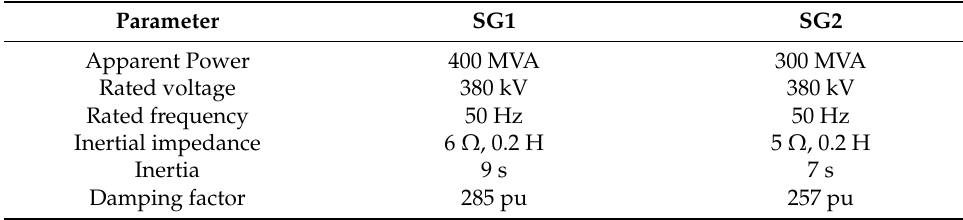
Table 1. The parameters of SG1 and SG2.